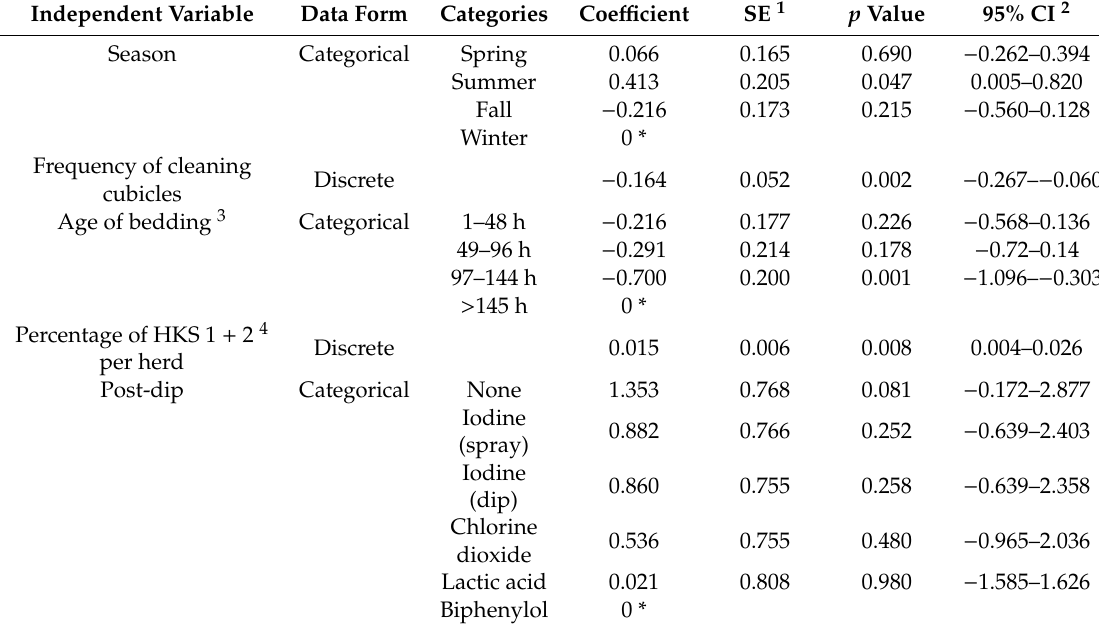
Table 6. Final generalized linear mixed model based on 120 farm visits describing risk factors ( = independent variable) associated with log 10 -transformed teat-skin load at herd level with coliform bacteria ( = dependent